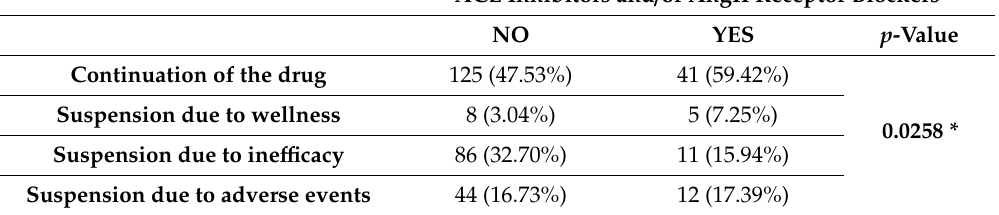
Table 7. Association between outcome of biologic therapy at LoT visit and exposure to ACEis / ARBs (* Chi-Square